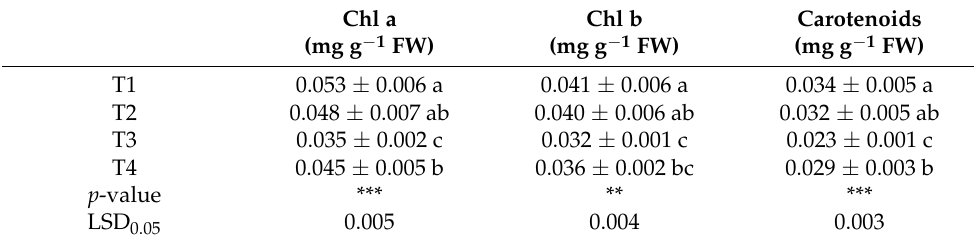
Table 1. Photosynthetic pigment concentrations in spears from the four different plots: